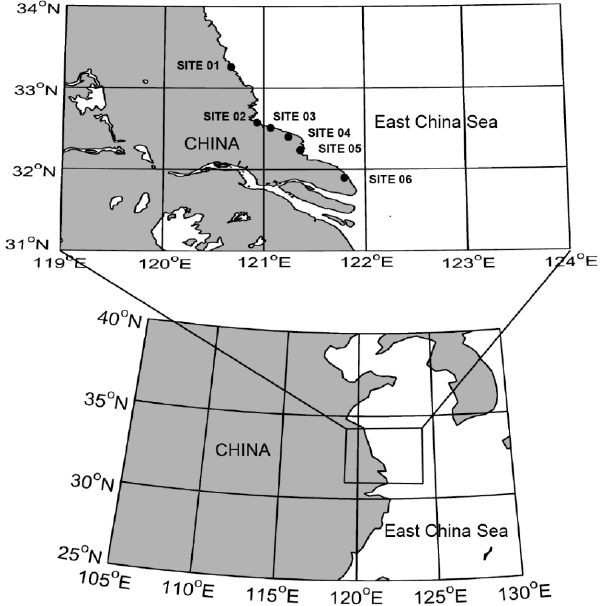
Figure 2. Location of the six wind farms used in this study, denoted by black dots.